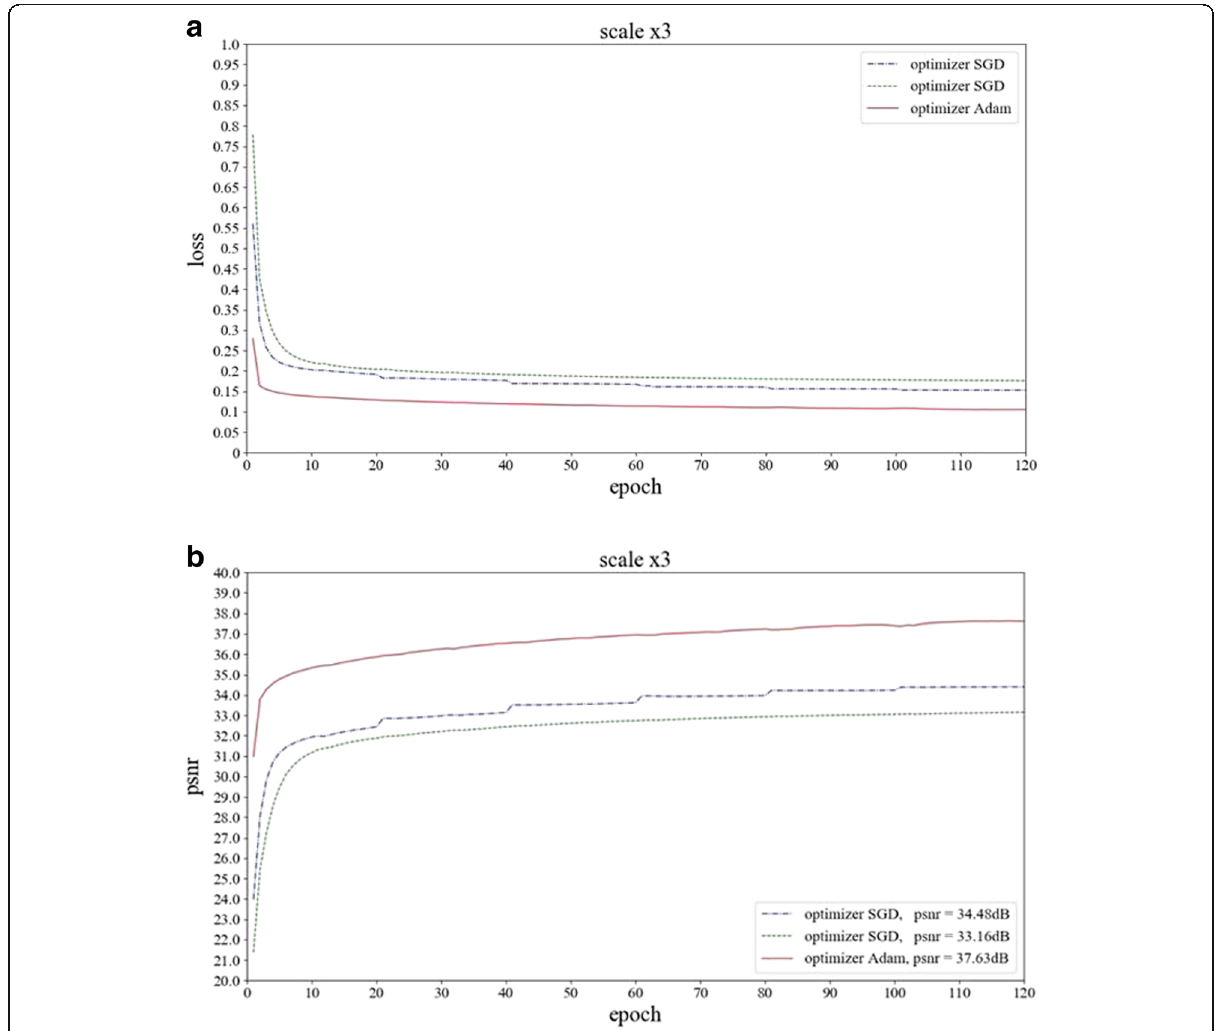
Fig. 5 The experimental results of different learning